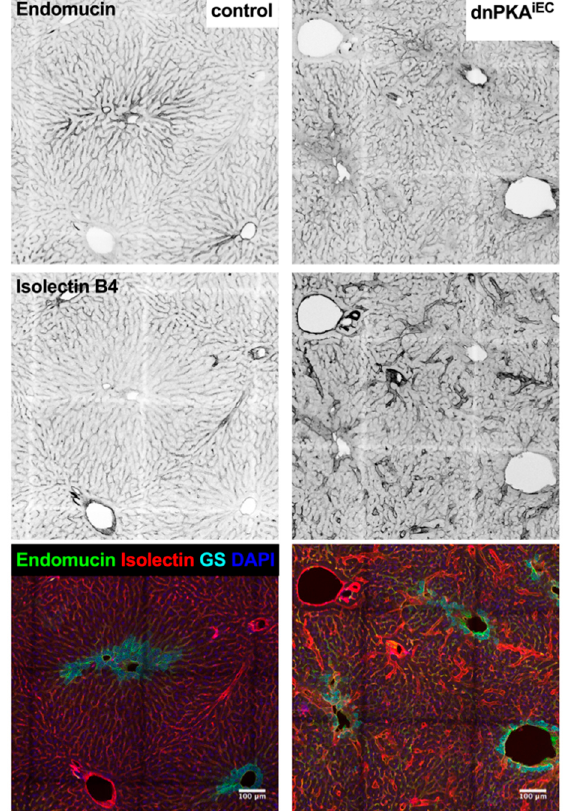
Figure 10. Hepatocyte zonation is preserved in dnPKA iEC mice. Liver slices of control (Tg(Cdh5- cre/ERT2)1Rha without floxed transgenes) and dnPKA iEC mice were stained for endomucin ( upper panels) or isolectin B4 ( middle panels). Expression of endomucin-positive cells and cells stained with isolectin B4 demonstrate remarkable spatial distribution in control mice ( left panels) with high levels of endomucin and low levels of isolectin B4 staining around the central vein (identified by expression of glutamine synthetase in hepatocytes surrounding the central vein, GS; cyan in lower panels). Disorganization of the hepatic vasculature in dnPKA iEC mice was evident throughout all liver zones ( right panels). Scale bar, 100 µm. Mice were injected with tamoxifen at the age of 28–32 days and dissected at the age of 67–72 days.